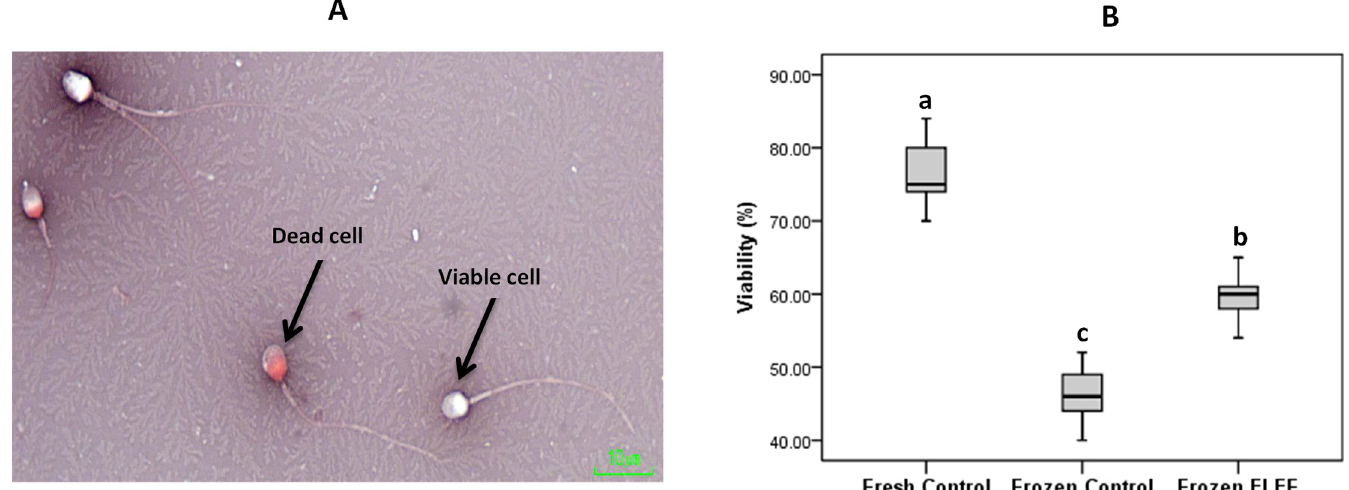
Fig 3. Effect of ELEF on percentages of living sperm. (A) Photography of dead (red) and viable (white) spermatozoa in eosin-nigrosin staining. (B) Box-and-whisker plots for sperm viability. The boxes represent the 25th and 75th percentiles; whiskers are lines extending from each end of the boxes covering the extent of the data on 1.5 × inter-quartile range. Middle lines that bisect the boxes represent the median value. The percentage of viable sperm in frozen control was significantly lower than that in fresh control and frozen ELEF (at 1000 Hz repetition rate with 60 min time period) using eosin-nigrosin protocol. The assigned letters of a, b and c indicate significant differences (p < 0.05) among the groups. Values are expressed as mean ±